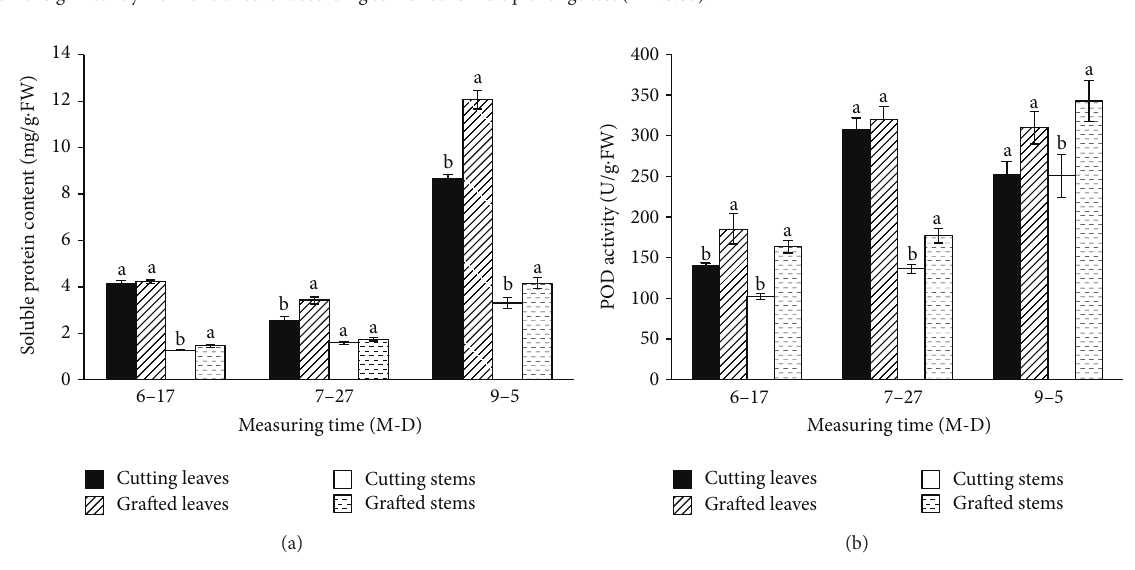
Figure 1: The contents of soluble protein and POD activity in the nongrafted and grafted cuttings. H1: cuttings harvested on June 17; H3: cuttings harvested on July 27; H5: cuttings harvested on September 5; means and standard errors calculated from three replicates. Significance ( 𝑃 < 0.05 ) indicated by lower case lettering ((a), (b)), derived using the Duncan’s multiple range